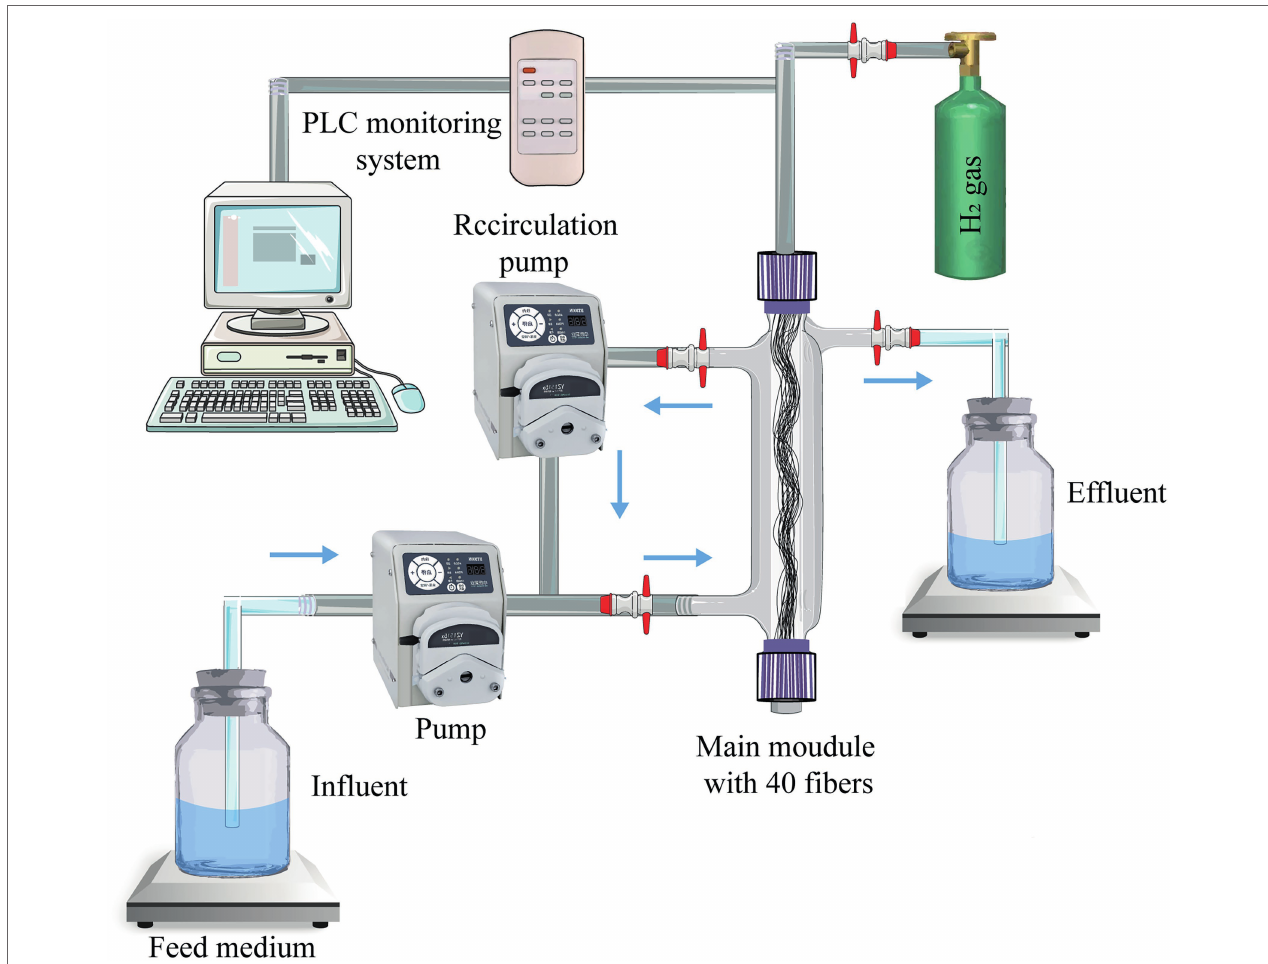
FIGURE 1 | Schematic of the hydrogen-based membrane biofilm reactor (MBfR) used to investigate nitrate